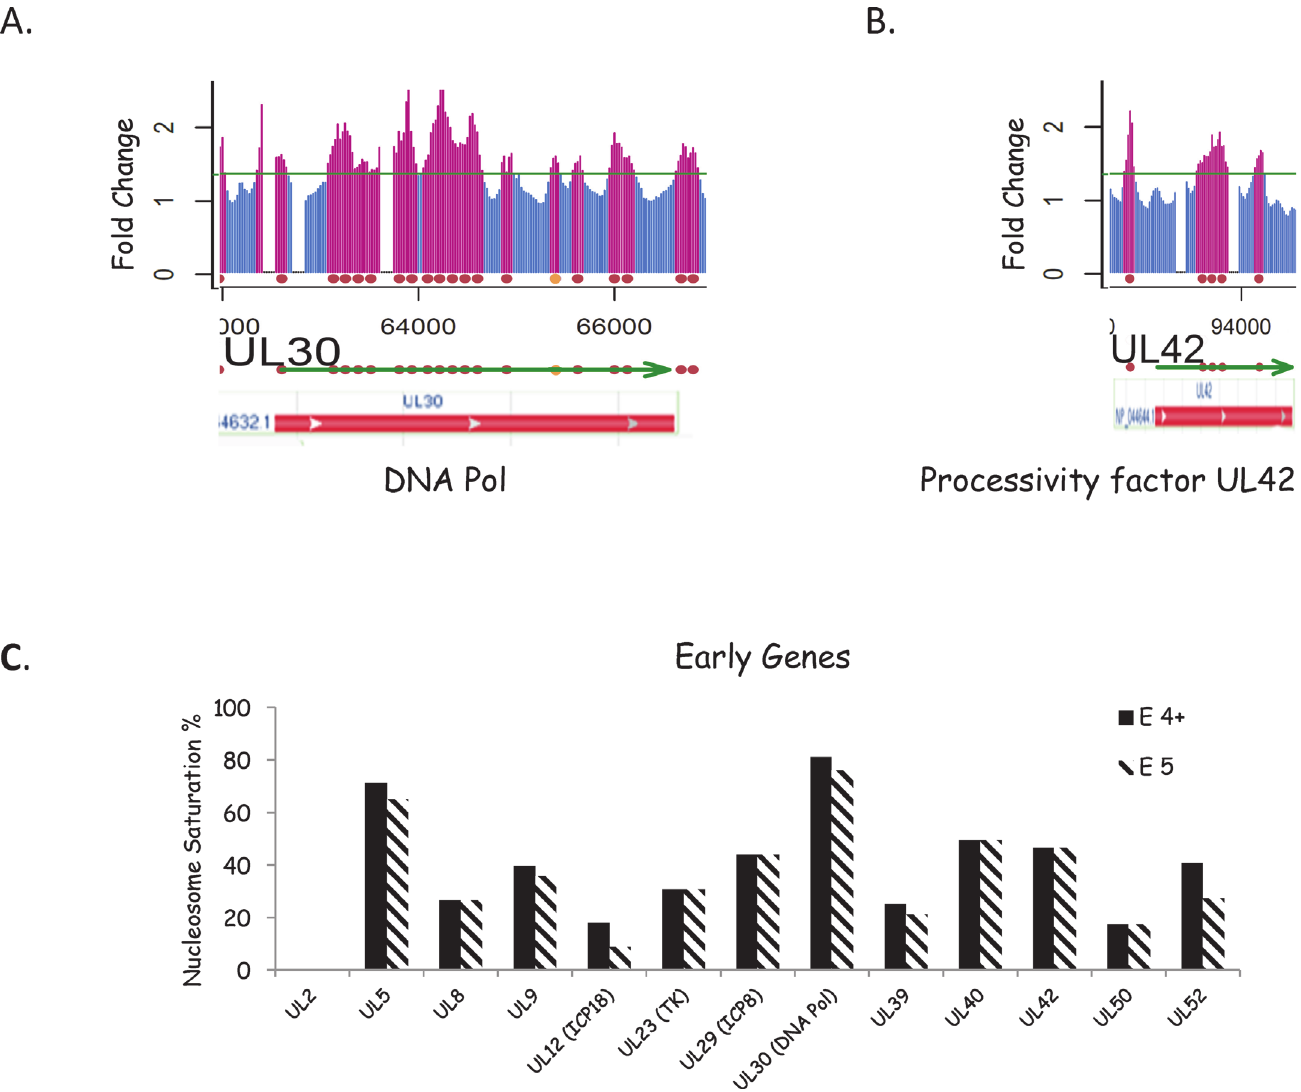
Fig 5. Nucleosomes on Early genes. A. and B The nucleosome signal is shown in the region covering the gene for DNA polymerase (UL30) and its processivity factor (UL41). There is one copy of these genes located in the unique long segment of the viral gene. Below the array signal information we have mapped the transcribed gene and the red or orange balls indicate the predicted position of nucleosomes. Gene features from the NCIB database are also shown. C . Nucleosome Saturation for each E gene. The predicted nucleosomes for each E gene were compared to the maximum number of nucleosomes (assuming a 200nt/nucleosome repeat pattern) to give the nucleosome saturation, which is expressed as a